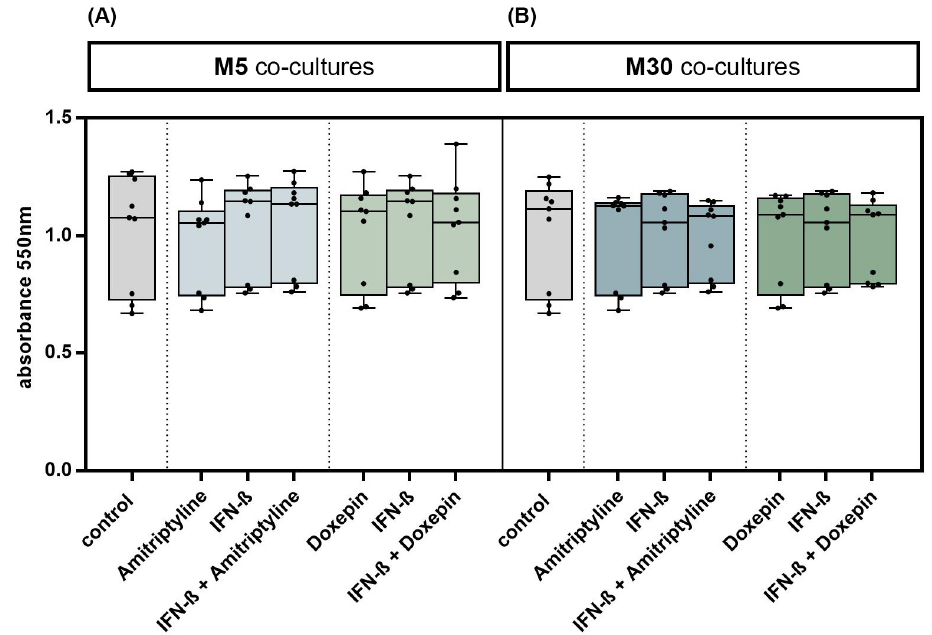
Figure 2. Glial cell viability was measured using MTT assay. Physiological (M5) ( A ) and pathological (M30) ( B ) astrocyte–microglia co-cultures were incubated with either 10 ng/mL amitriptyline or doxepin for 2 h, or with 2000 U/mL interferon- β (IFN- β ) for 22 h. To investigate additional effects of antidepressants on IFN- β , cell cultures were pre-incubated with IFN- β (2000 U/mL) for 22 h and subsequently co-incubated with amitriptyline or doxepin for 2 h ( n = 9). Untreated co-cultures were used as controls. The individual experimental conditions were compared by two tailed t -test. No significant differences between the individual conditions were detected ( p = ns).